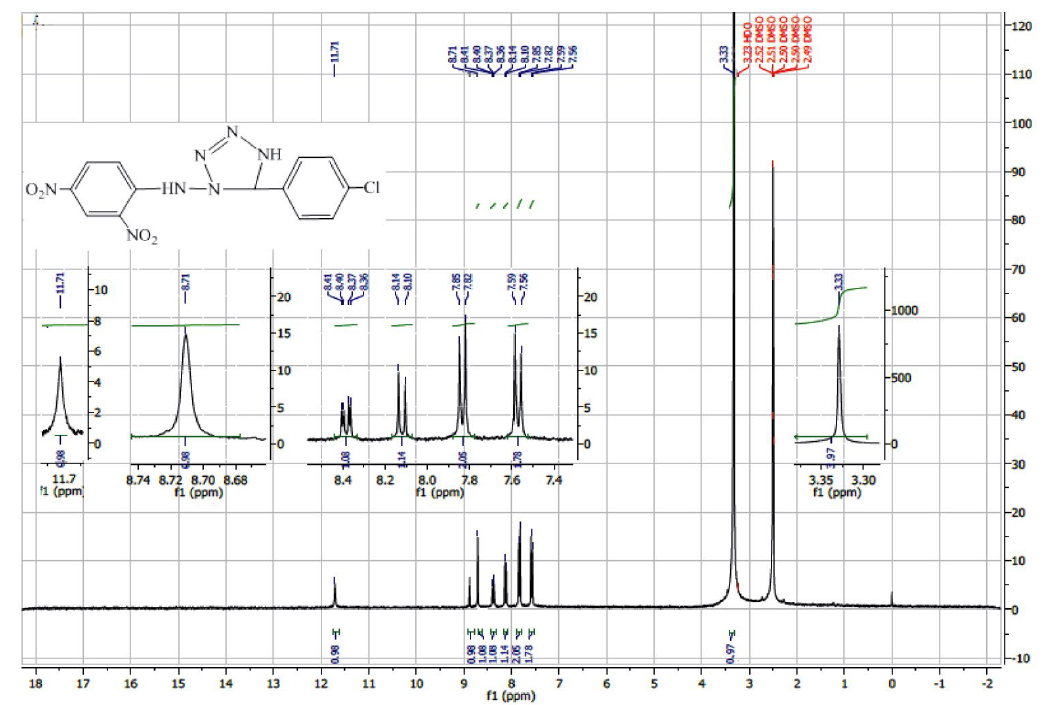
Figure 2. 1 H NMR Spectrum of I 8